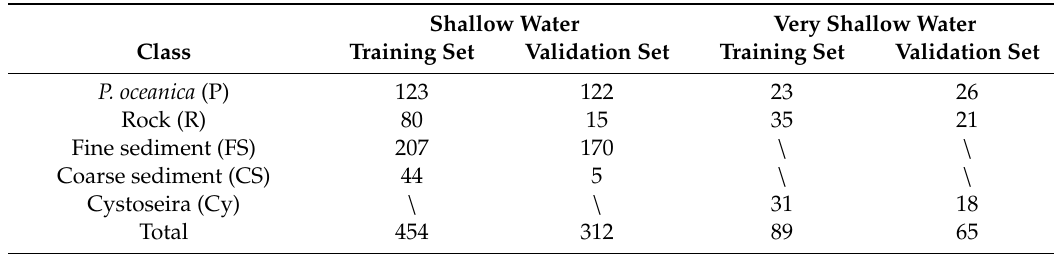
Table 3. Main thematic classes of seabed and number of ground-truth data collected through the ASV DEVVS, UTCS, UAVs and derived by the acoustic data. Shallow Water Very Shallow Water Training